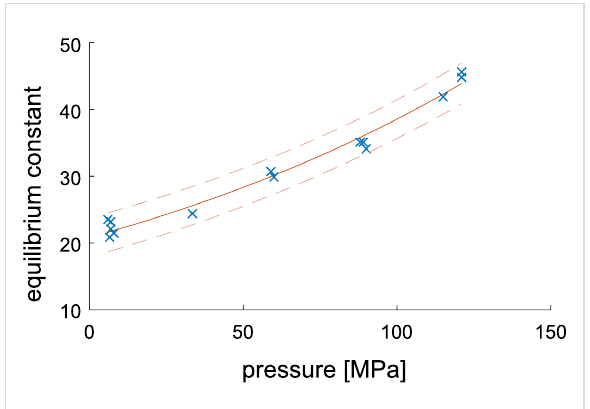
Figure 13: Aldolase: Change of the equilibrium constant at different pressures. Starting concentrations were varied: 100 mM with 250 mM and 100 mM with 100 mM of ManNAc and pyruvate, respectively. Conditions: 41 °C, reaction time at least 12 h, total working volume 4 mL, flow rate 1.5 mL/min, 272.3 mg particles loaded with aldolase. The used regression is an exponential fit according to Equation 5.